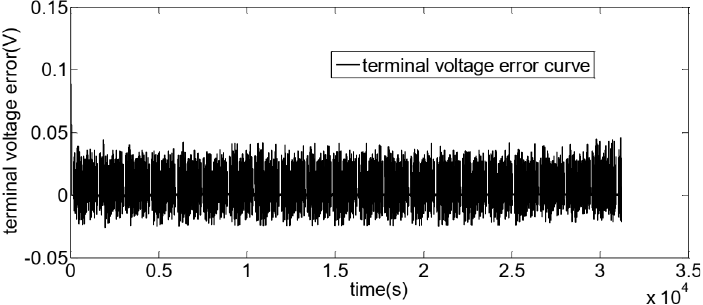
Figure 10. The terminal voltage error curve.